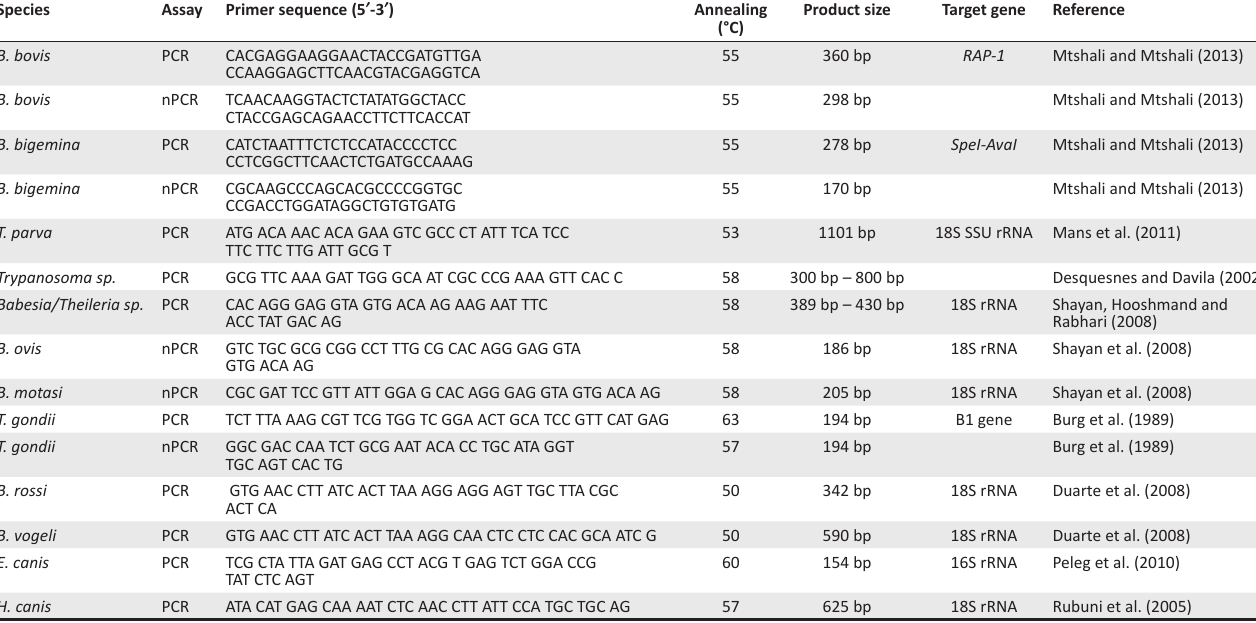
TABLE 1: Sequences of primers used for polymerase chain reaction amplification of protozoan parasites and Ehrlichia canis. Species